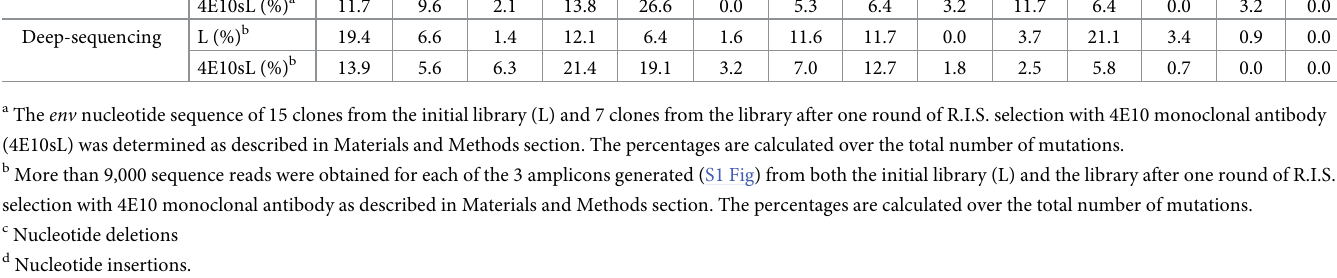
Table 1. Envelope gene mutations in virion libraries determined by standard and deep-sequencing before and after selection.